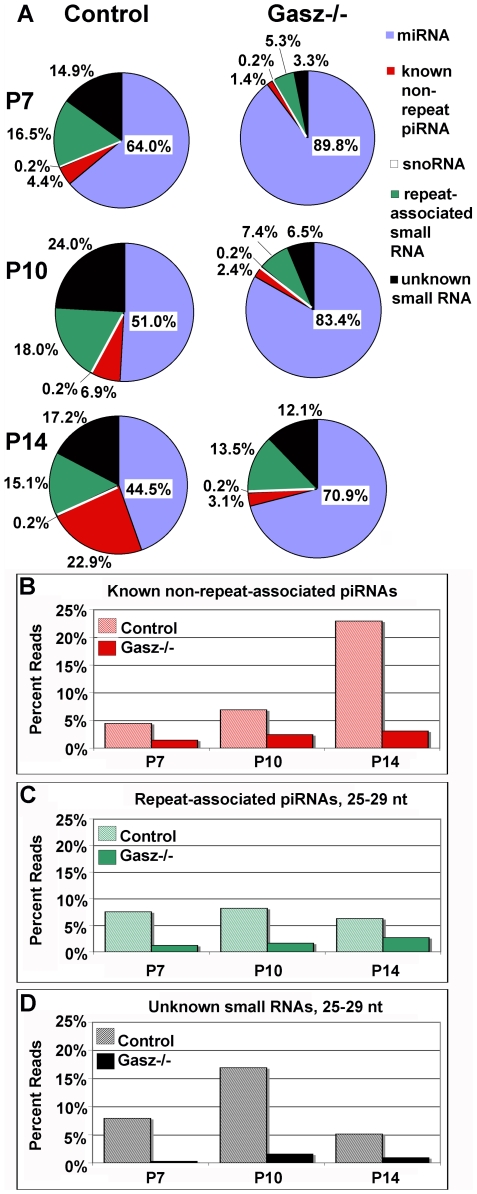
Repeat and non-repeat piRNAs regulated by GASZ.(A) Compositional analysis of small RNA populations at postnatal days 7 (P7), 10 (P10), and 14 (P14) in Gasz
+/− (Left) and Gasz
−/− (Right) testes with annotation of small RNA populations as described in experimental procedures. (B–D) Comparison of the relative abundance of several classes of known and putative novel piRNAs between Gasz
−/− and control testes at postnatal days 7, 10, and 14 including known non-repeat-associated piRNAs (B), repeat-associated piRNAs (25–29 nt) (C) and unknown small RNAs (25–29 nt) (D).